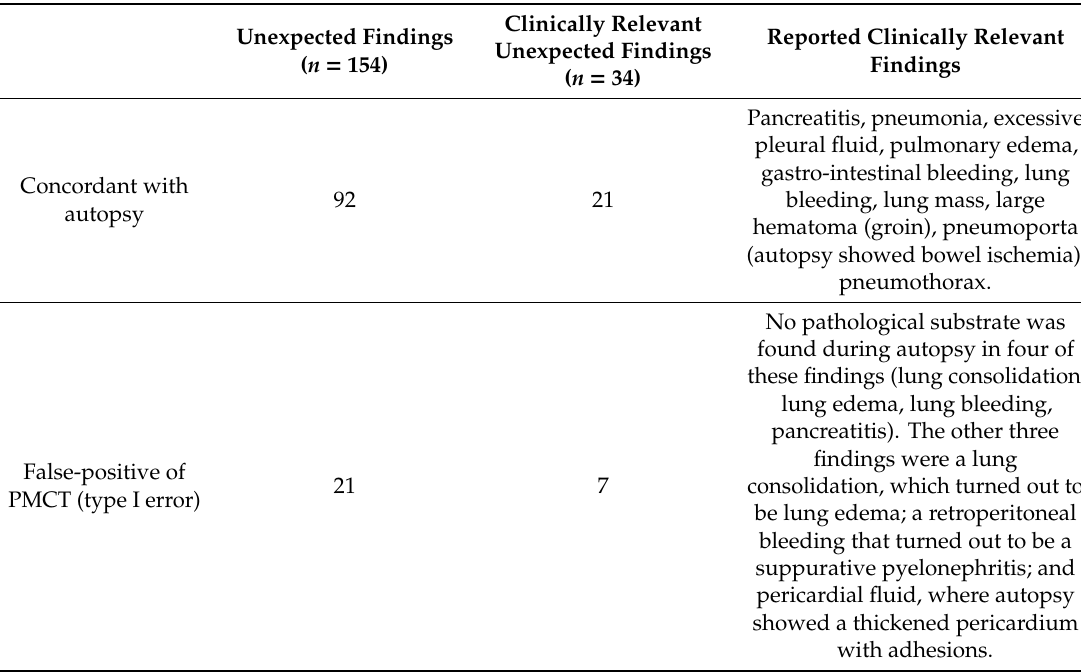
Figure 1. Flowchart of post-mortem computed tomography (PMCT) findings in the autopsy subgroup of 57 decedents. The findings are classified according to Goldman. Table 2. Clinically relevant unexpected findings divided into four groups of findings: findings concordant with autopsy (true-positive), false-positive findings of PMCT (type I error), false-negative findings of autopsy (type II error), and findings visualized with PMCT in the absence of brain autopsy. For each group, the findings are reported in the last